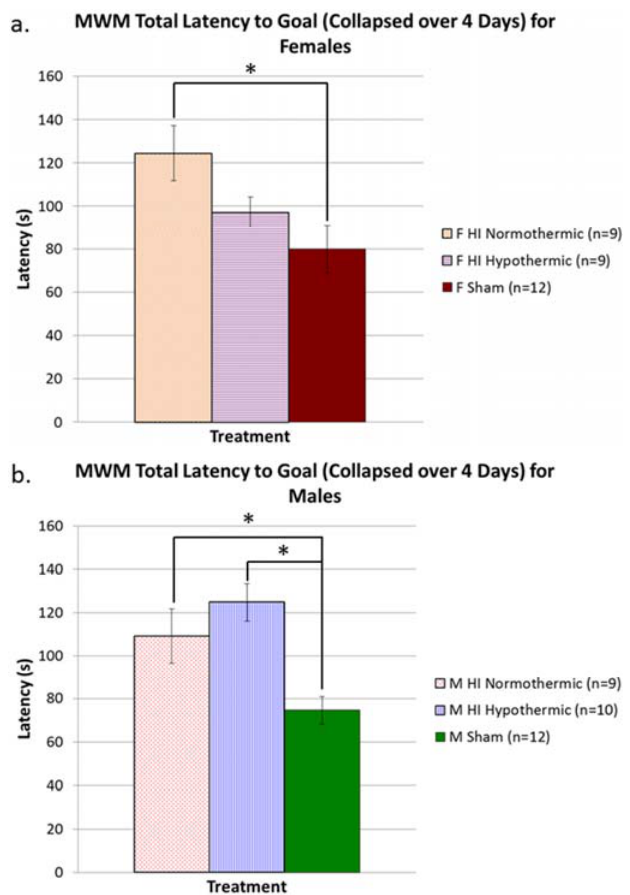
Figure 3. ( a ) A one-way ANOVA to assess Treatment effects revealed